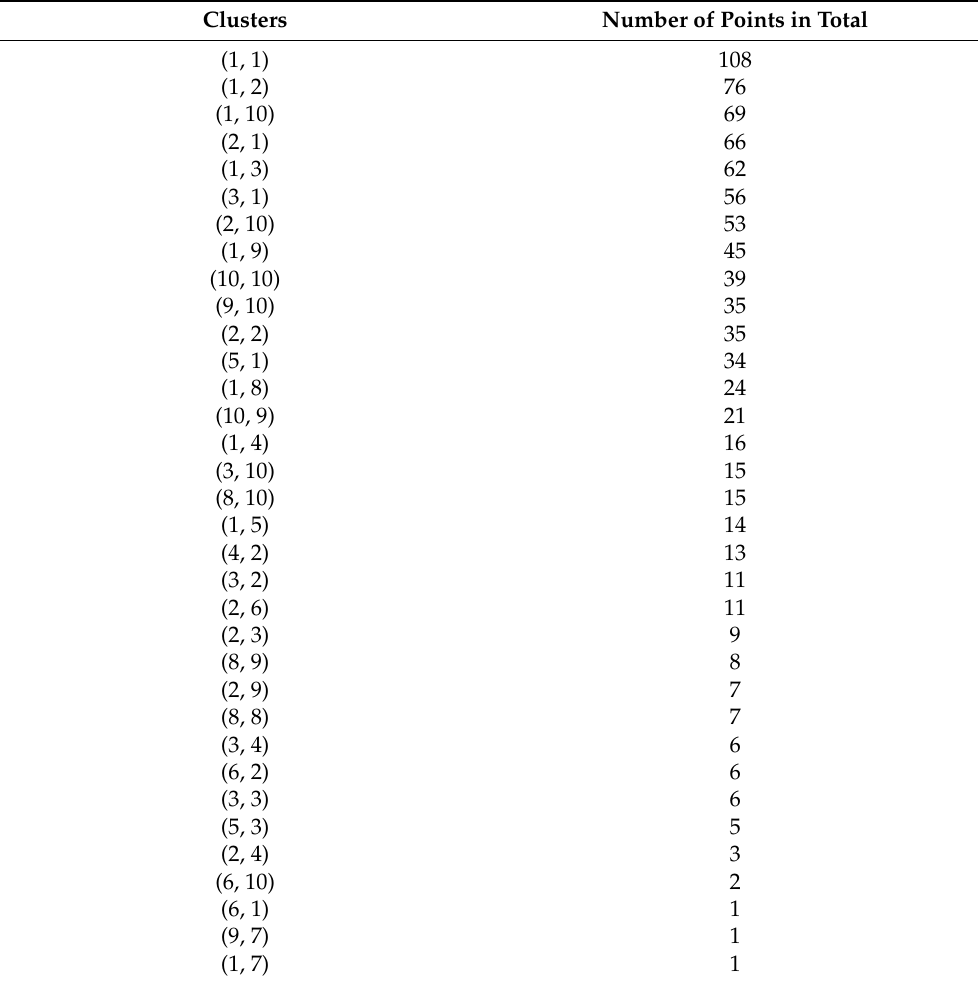
Table A2. Overall ranking of